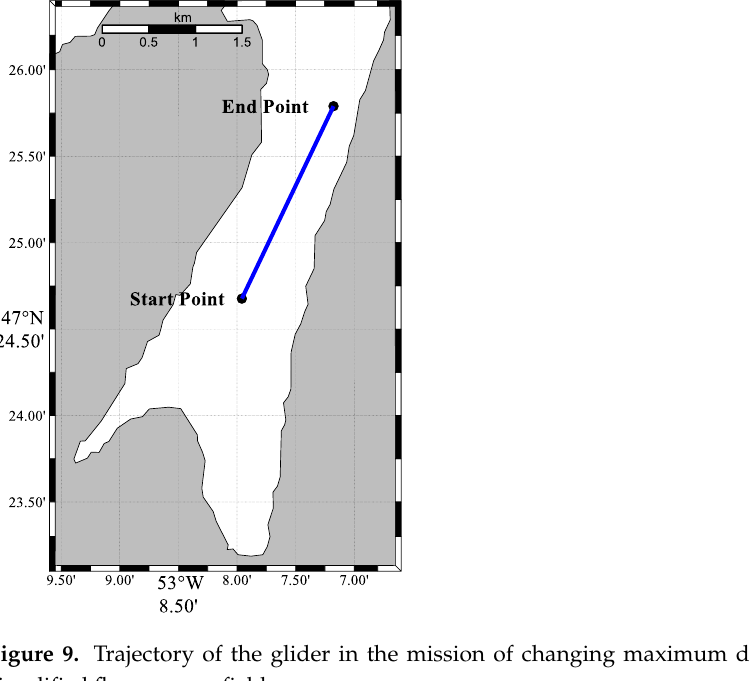
Figure 9. The mission was ended when the distance to the end point was within 10 m.